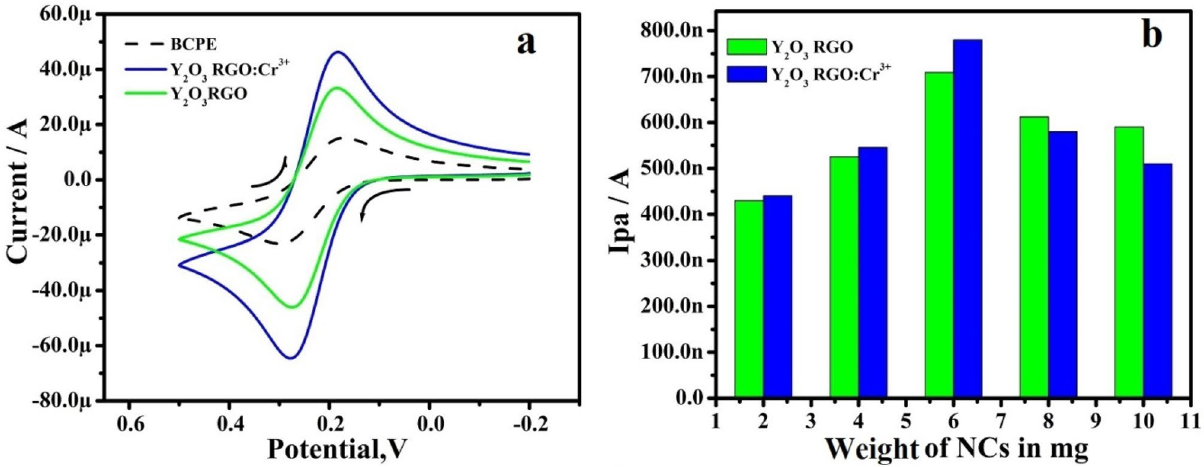
Figure 4. (a) CVs of 1 mM potassium ferrocyanide in 1 M KCl solution at scan rate 50 mVs -1 . ( b) Plot of Ipa versus weight of